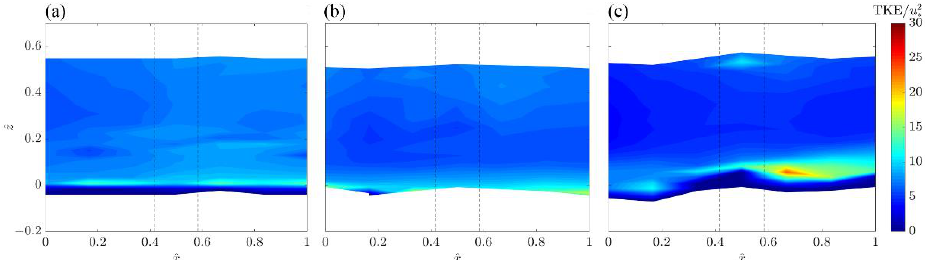
Figure 12. Contours of the dimensionless TKE in the longitudinal plane section (from RE to RV) for ( a ) Run 1, ( b ) Run 2 and ( c ) Run 3. The black dashed lines show the cylinder position.